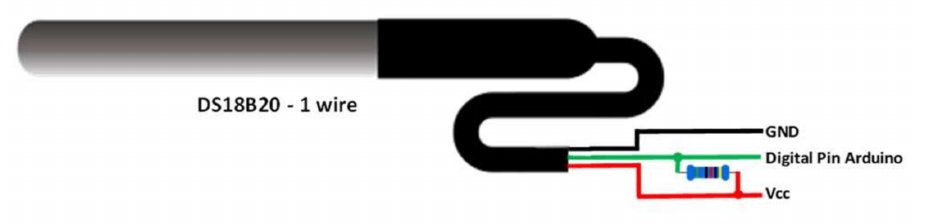
Figure 4. Connections for DS18B20.